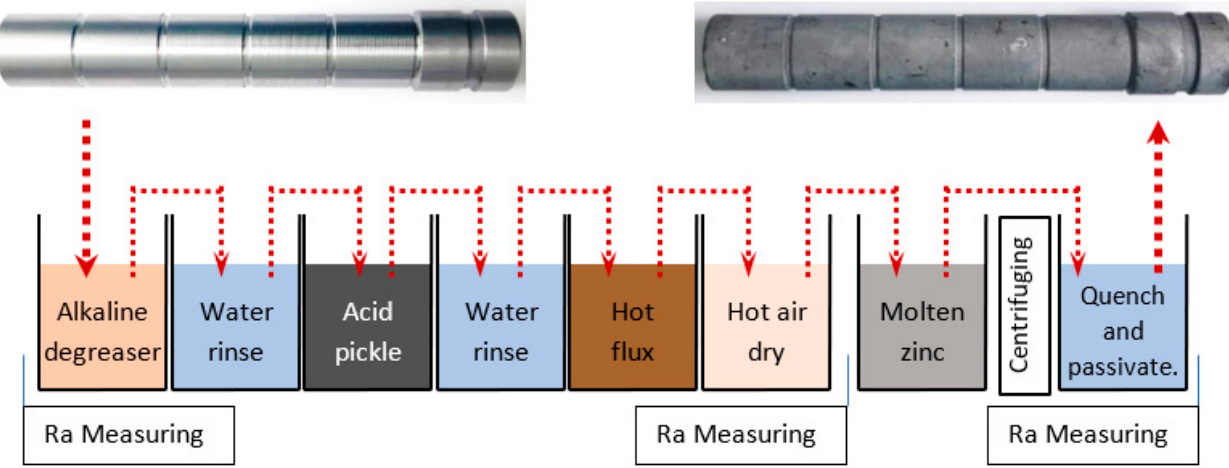
Figure 5. The technological flow specific to hot dip galvanizing and centrifugation.